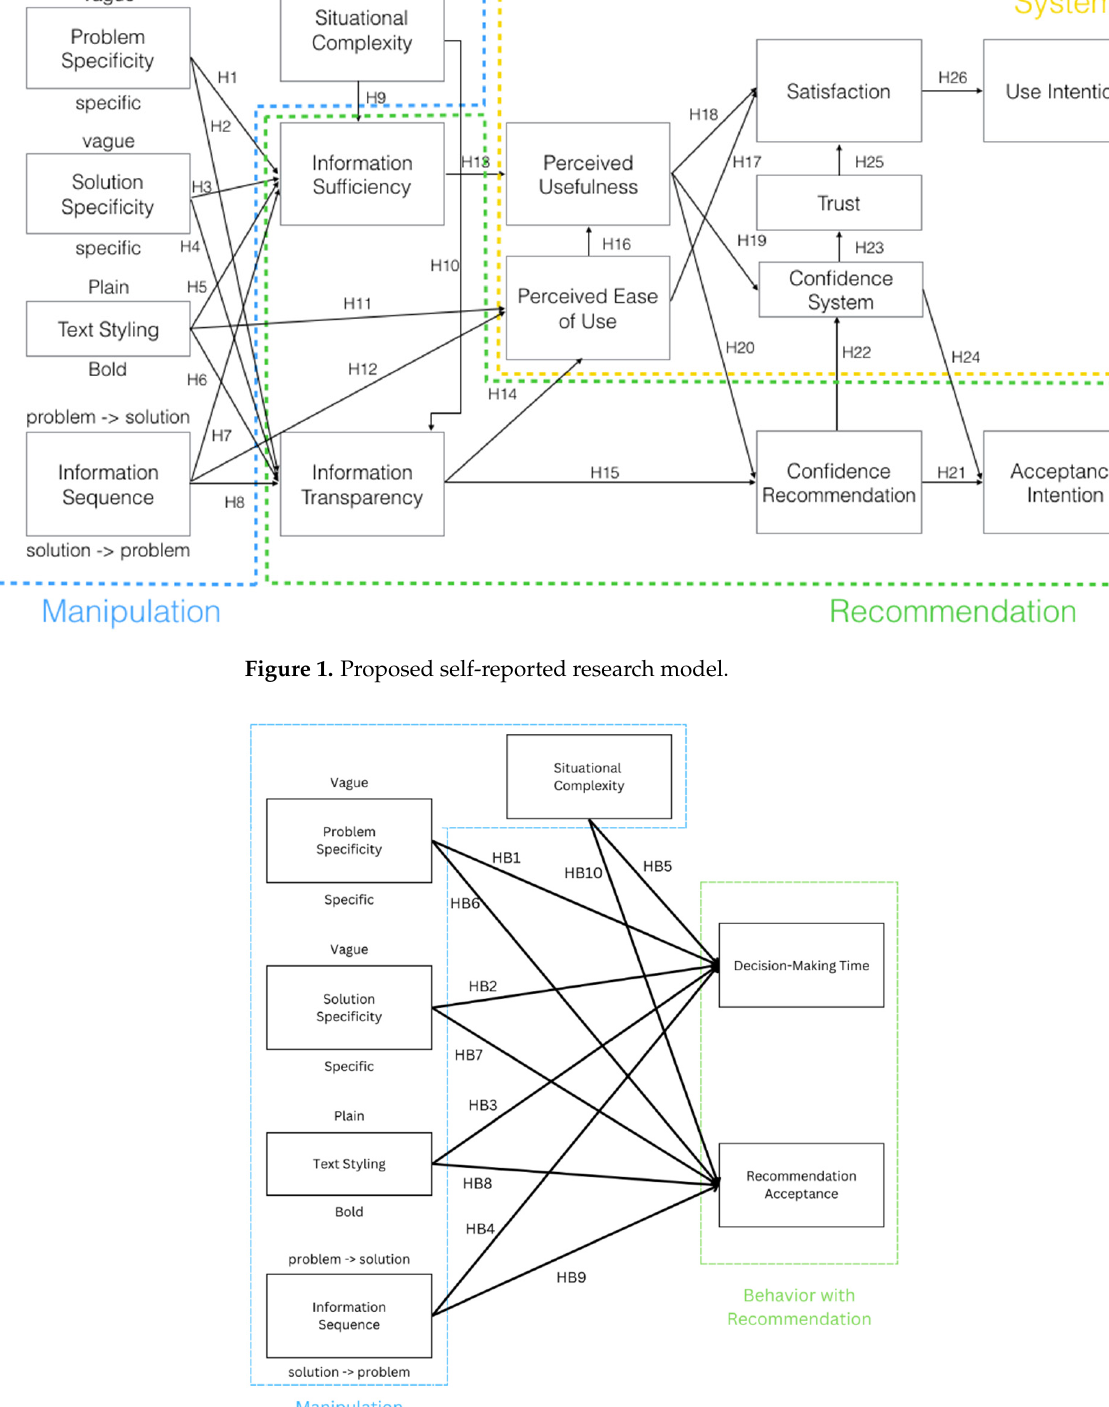
Figure 2. Proposed behavioral research model.